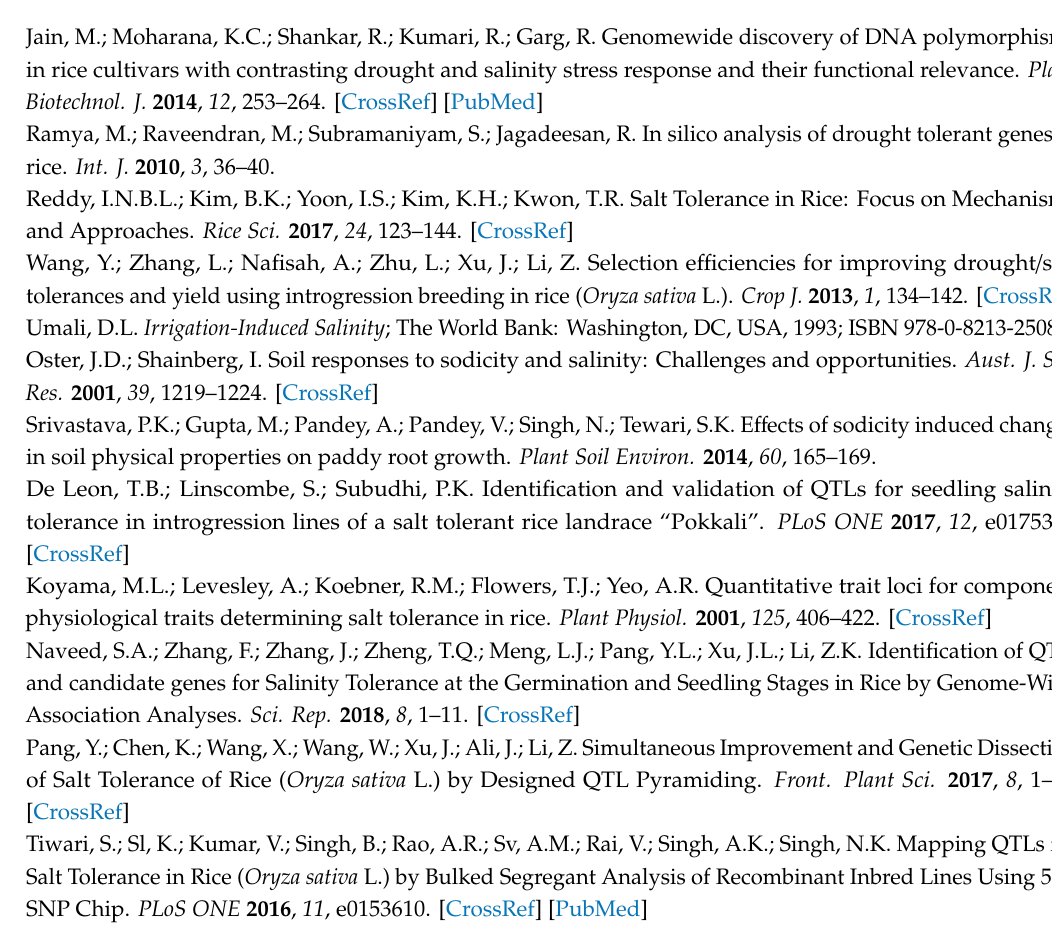
Supplementary Table S1. Supporting references for QTL hotspots co-located in the same chromosomal regions reported in other breeding studies. Supplementary Table S2. Variants identified in abiotic stress-related genes with reference to Nipponbare genome. Supplementary Table S3. Abiotic stress-related cis acting elements revealed by the analysis of the promoter sequences of the genes with InDels. Supplementary Table S4. Candidate genes identified based on polymorphic SNPs in exons regions of two parents. Supplementary Table S5. GO analysis of the selected candidate genes. Supplementary Table S6. Presence of InDels in the selected rice panels. Supplementary Figure S1. InDels detected in the candidate genes and their sequence validation. A. Os01g0581400 B. Os10g0107000 C. Os11g0655900 D. Os12g0622500 E. Os12g0624200 . Supplementary Table S7 Abiotic stress-related Cis acting elements revealed by the analysis of the promoter sequences of the genes with InDels. Supplementary Table S8 InDel marker